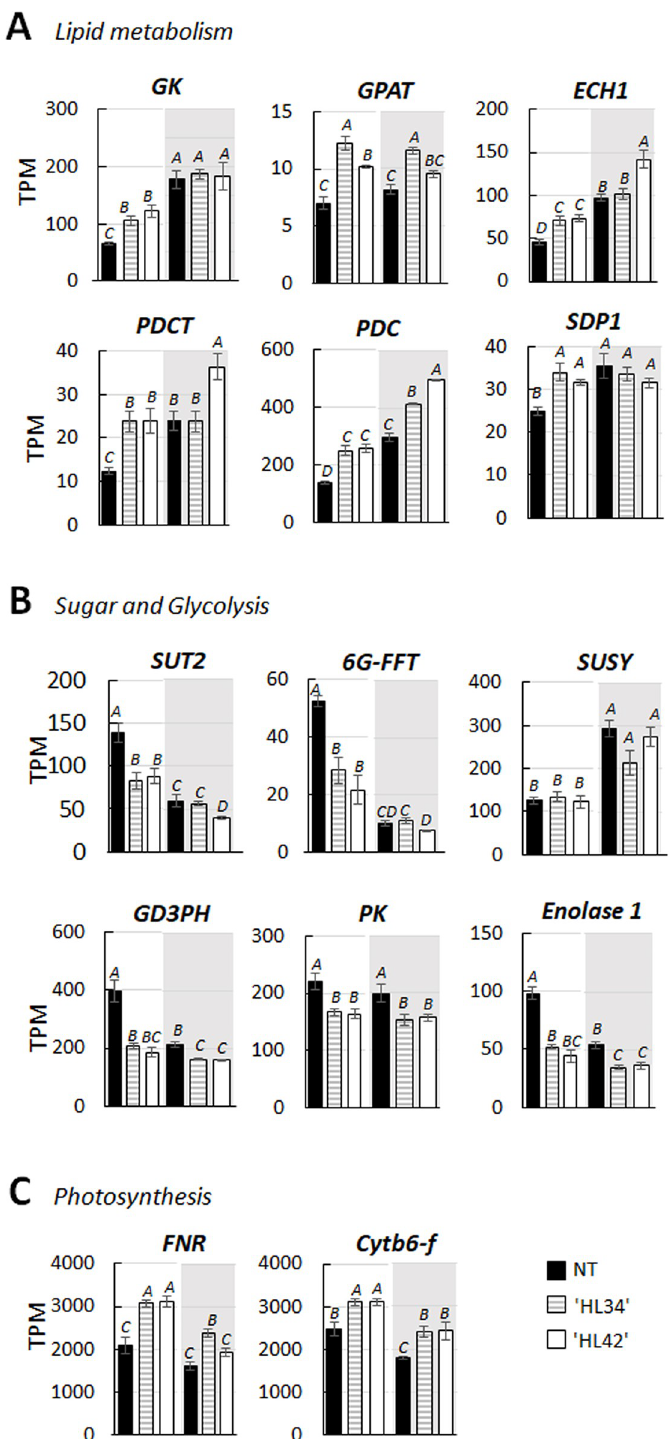
Fig 2. The relative gene expression level of differentially expressed genes (DEGs). Data represent the means of normalized transcript per million (TPM) with the error bar of the SE. DEGs were identified in high lipid (HL) ryegrass compared with non-transformant (NT) plants grown under standard (white graph area) and low (shading graph area) irradiance levels. A-D Alphabets indicated significant differences (p < 0.05, n = 3 ). DEGs grouped using Gene Ontology analysis as following: A lipid metabolism: Glycerol kinase ( GK , XP_015636240.1), glycerol-3-phosphate-2-O-